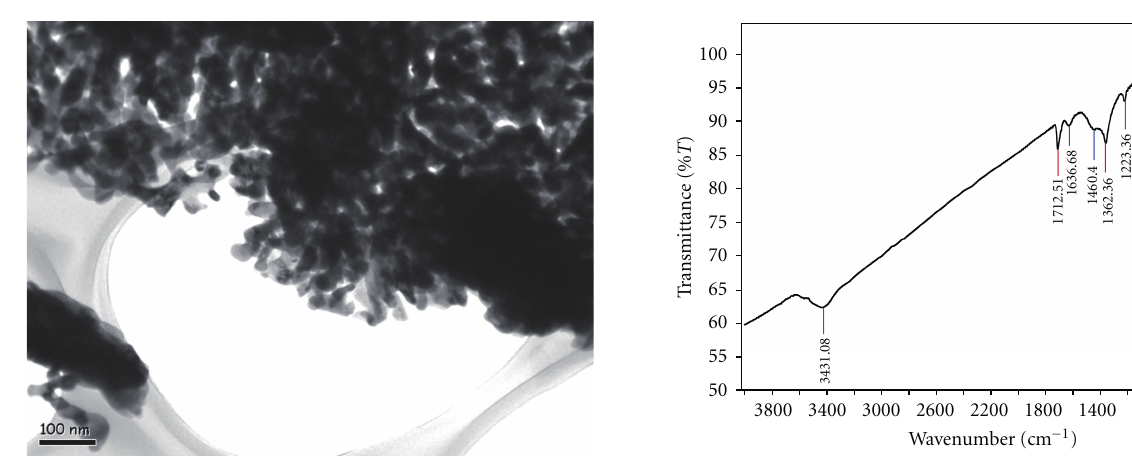
C. ∘ −1 may be resulting from interactions among Mn, OH,